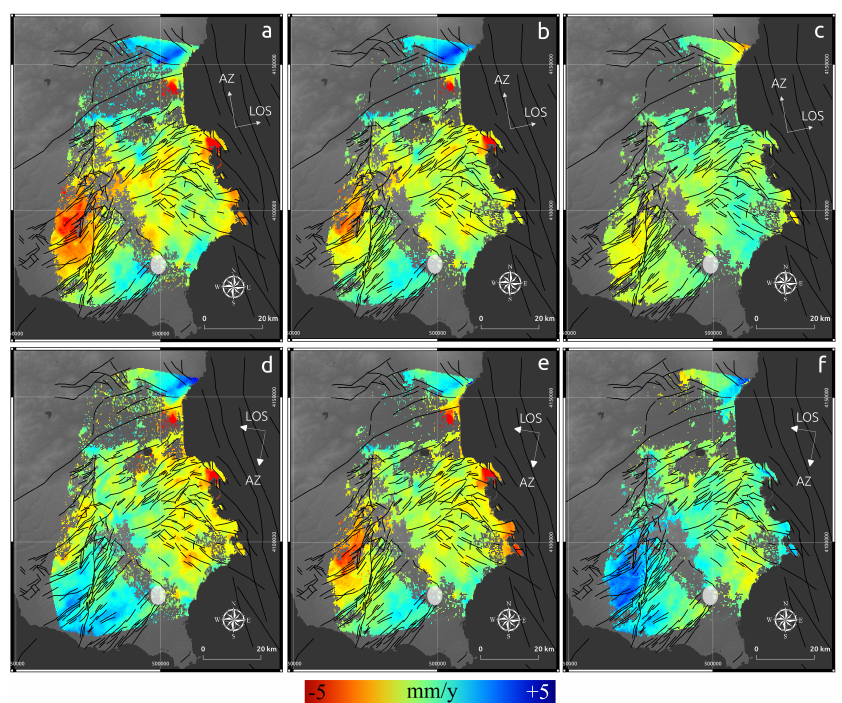
Figure 6. ( a – f ) Recalculation of the mean LOS velocities from the SISTEM output; upper row ascending track; lower row: descending track. ( a , d ) original LOS mean velocities; ( b , e ) predicted LOS mean velocities from the 3-dimensional SISTEM components; ( c , f ) residuals of the predicted mean LOS velocities with respect to the original LOS